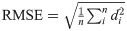
Visualising RMSE of summary statistics imputation and genotype imputation.This figure uses boxplots to compare the absolute difference |d| (used for calculation of RMSE) for each variant between Z-statistics of summary statistics imputation (SSimp, green) and genotype imputation (GTimp, blue) of associated SNVs (left column) and null SNVs (right column). Results are grouped according to MAF (x-axis) and imputation quality (rows) categories. The numbers printed above the boxplot represents the number of SNVs used for the |d| calculation in that MAF and imputation quality subgroup. The corresponding RMSE=1n∑indi2 is shown in Table 1.